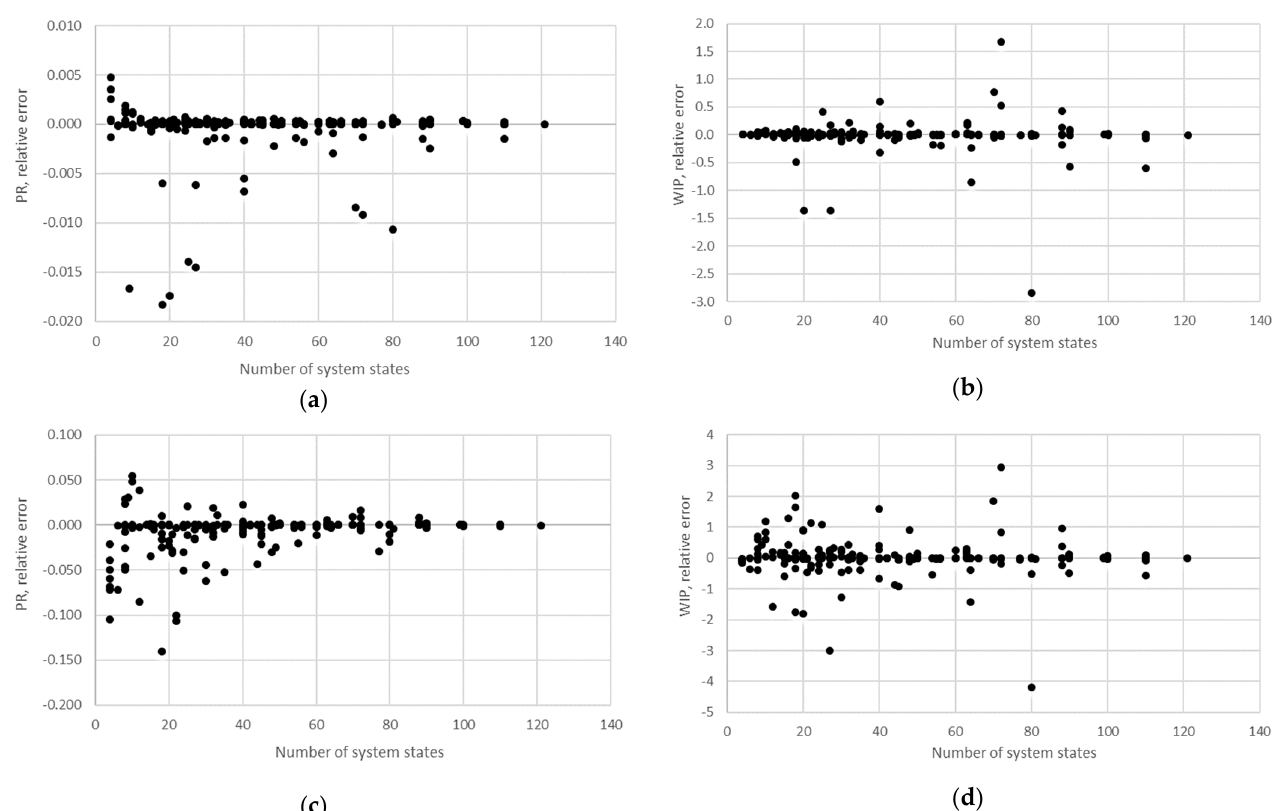
Figure 12. M = 3, relative error obtained using the ( a , b ) AGG procedure and ( c , d ) FSM.